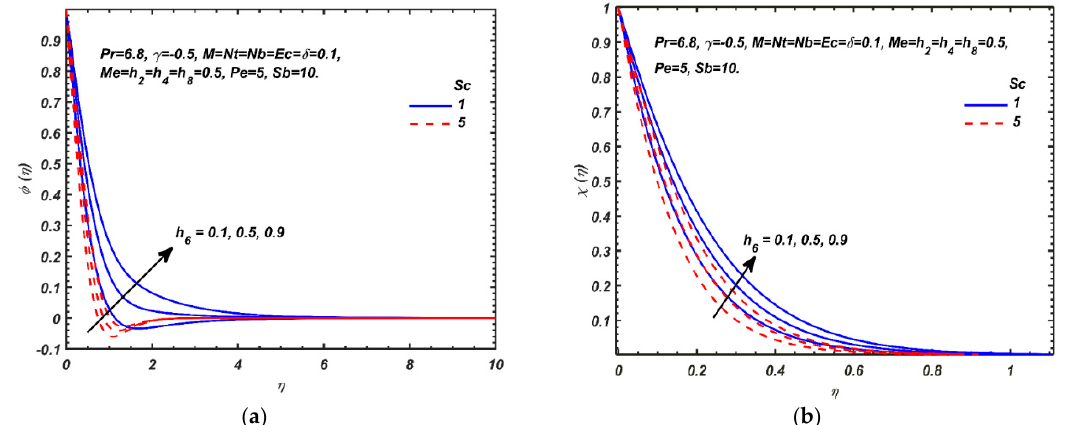
Figure 4. Effects h 6 and Sc on the dimensionless ( a ) nanoparticle volume fraction and ( b ) micro-organism density number function.